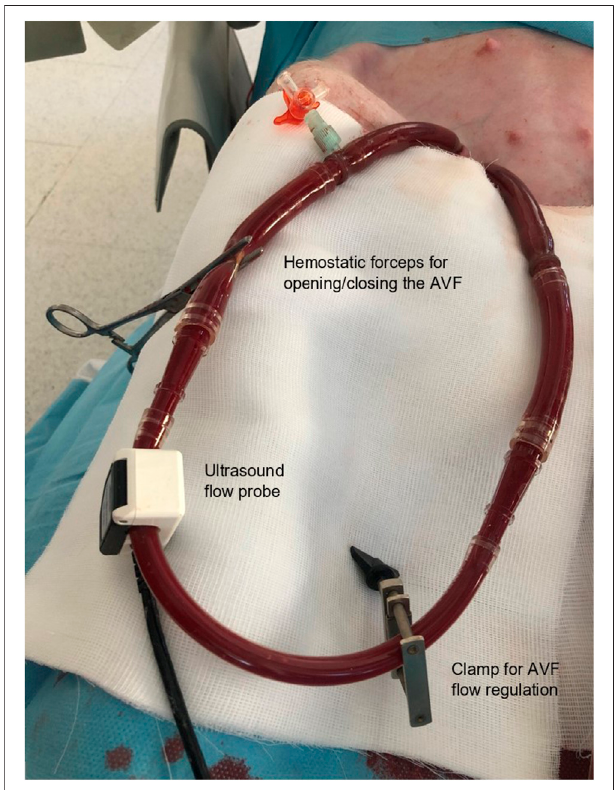
FIGURE 1 | Aortocaval arteriovenous fi stula created by the connection of two high-diameter ECMO cannulas. Special clamp to regulate the AVF blood fl ow volume was placed before connecting the ECMO cannulas (in lower right corner). Continuous measurement of AVF fl ow was performed using an ultrasound probe (arrow) (Transonic, United States). This photo documents clamping of the fi stula circuit by the hemostatic forceps for the observation of the hemodynamic stabilization in the fi nal phase of the